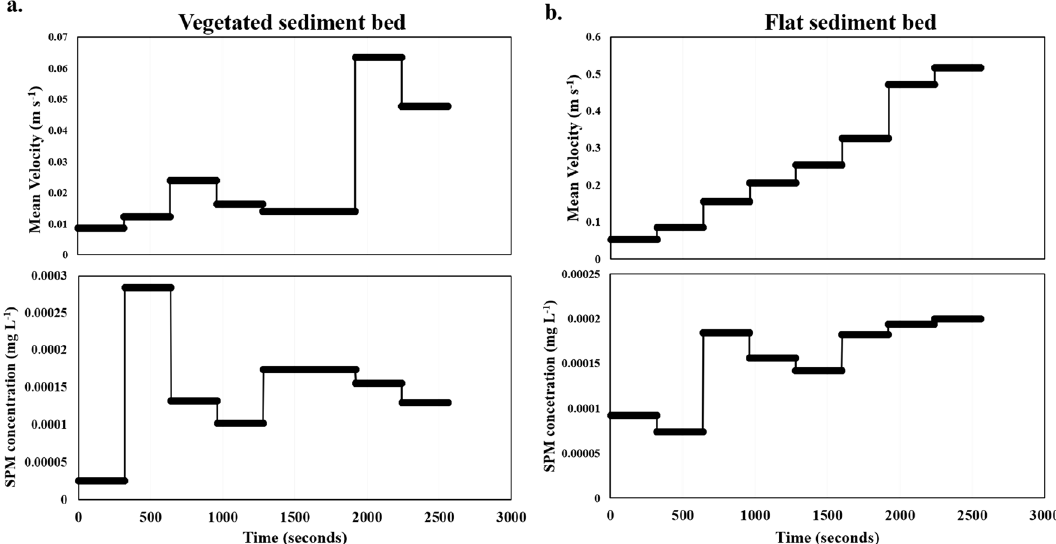
Figure 3. Time series plots of the suspended particulate matter (SPM) concentrations and mean velocity for ( a ) vegetated sediment bed and ( b ) flat sediment bed at a height of 3 cm above the bed (Profile